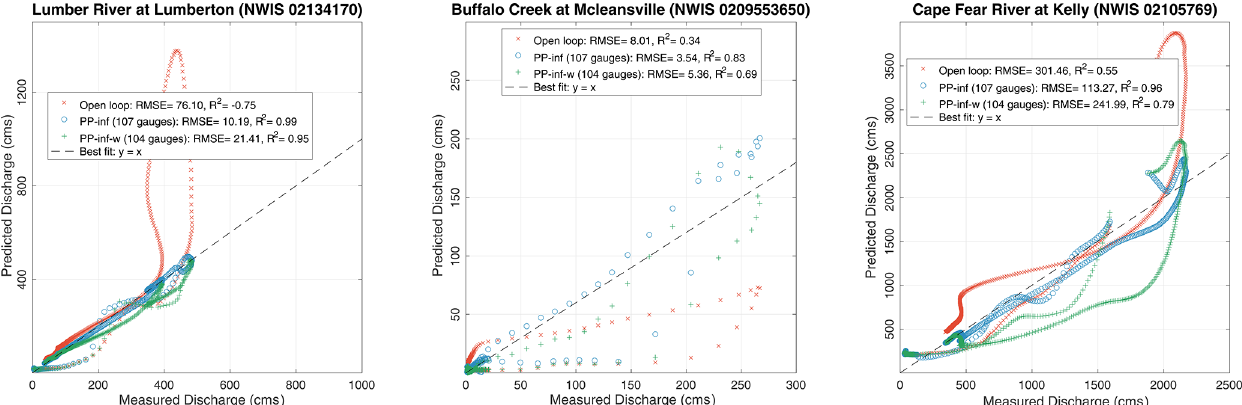
Figure 14. Cross-plots of the streamflow at three withheld gauges. The results are shown for the open loop, the PP-inf (where all 107 gauges are assimilated), and PP-inf-w (where only 104 gauges are assimilated). The best-fit line is denoted by a black dashed line. The average RMSE value and the coefficient of determination ( R 2 ) are computed and reported in the